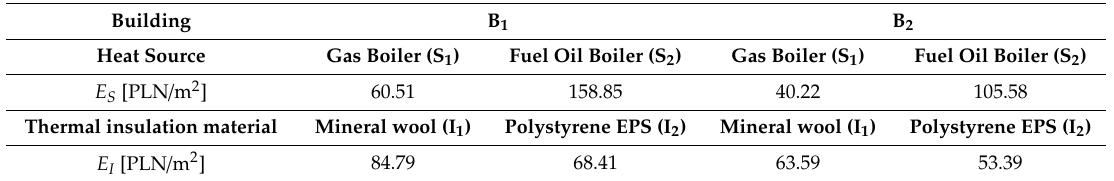
Table 10. Economic costs of replacing the boiler E S and economic costs associated with thermal insulation E